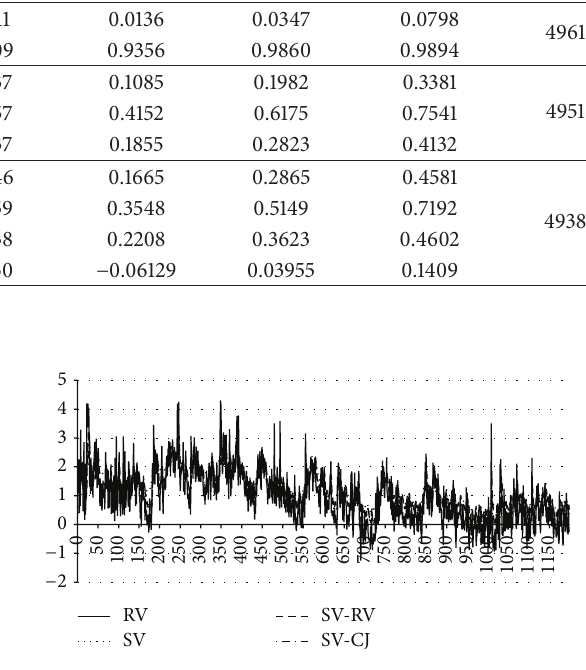
Figure 1: Comparison of the in-sample forecasting performance of the SV, SV-RV, and SV-CJ model. In the figure, RV represents the true volatility; SV, SV-RV, and SV-CJ represent the forecast volatility of the SV, SV-RV, and SV-CJ model,